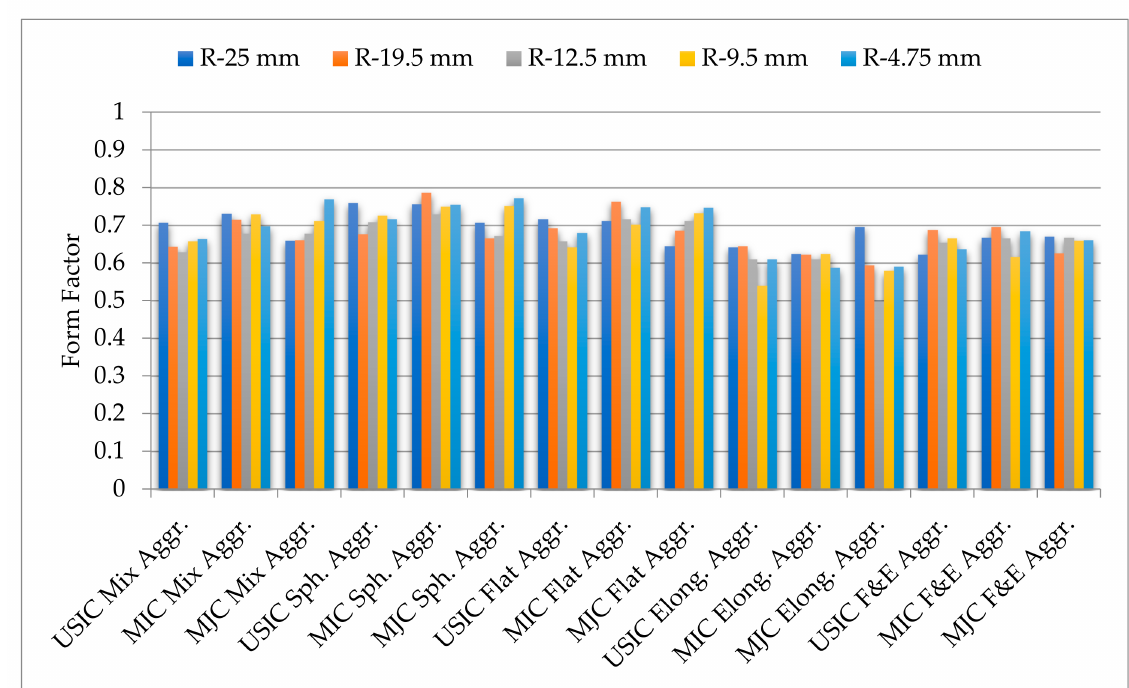
Figure 7. Form factor of different shapes of aggregates and types of